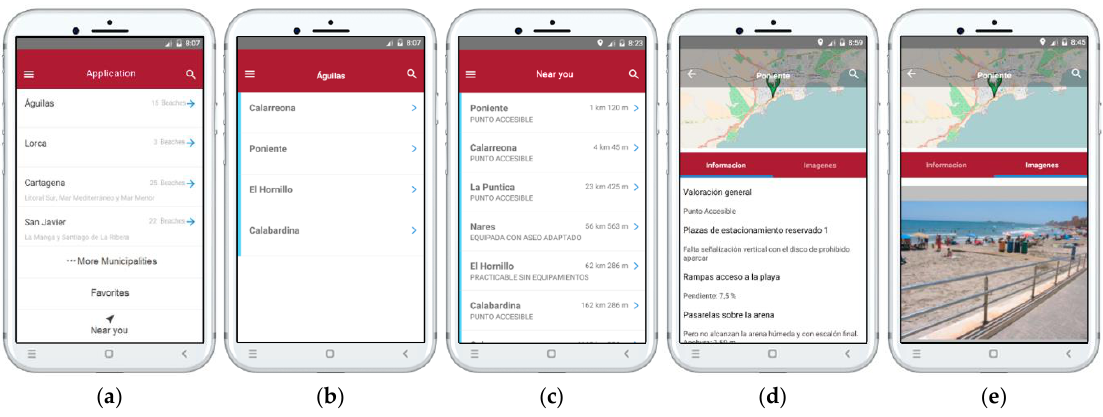
Figure 6. Sample screens of the proposed application [24]. ( a ) Initial screen. ( b ) List of beaches by municipality. ( c ) Search by proximity. ( d ) Information of a beach. ( e ) Images of a beach.